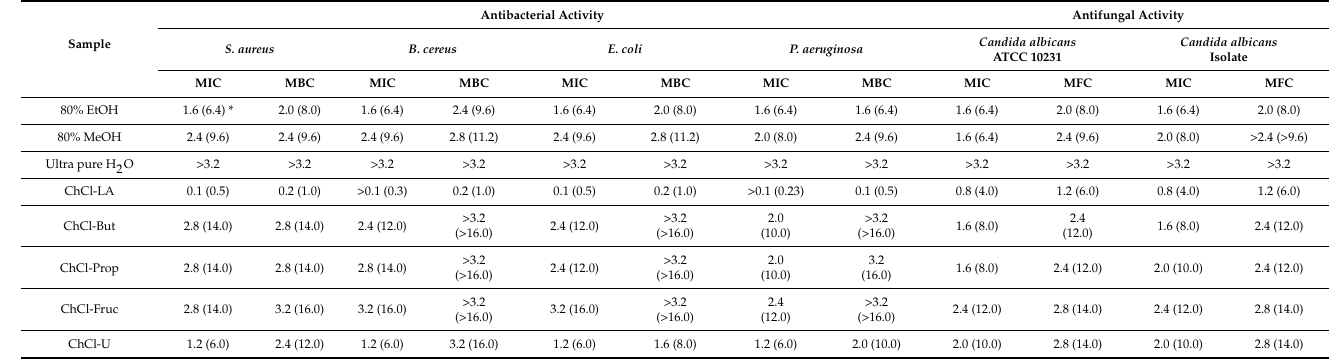
Table 4. Antibacterial (MIC and MBC in mg mL − 1 ) and antifungal (MIC and MFC in mg mL − 1 ) activity of A. millefolium extracts obtained after UAE at an elevated (50 ◦